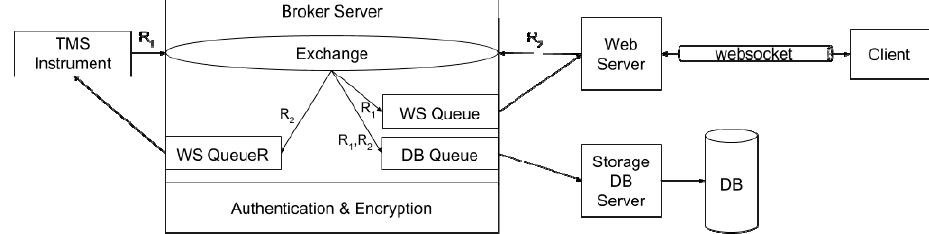
Figure 3. The architecture of the AMQP ‐ based solutions. The Authentication & Encryption tier is natively supported by the AMQP protocol.